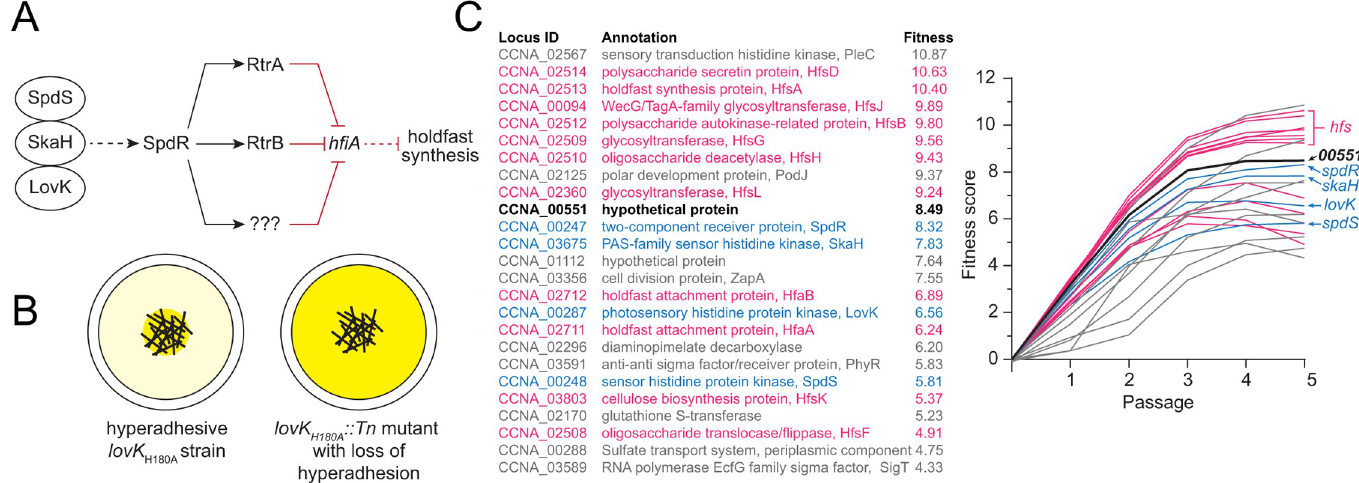
Fig 1. Adhesion TCS pathway and adhesion profiling of lovK H180A :: Tn mutants. A) Schematic of the LovK-SpdSR-SkaH adhesion TCS system that regulates holdfast synthesis as described by Reyes-Ruiz et al. [16]. Question marks indicate postulated additional regulator(s) in the adhesion control pathway. Dashed lines indicate post- transcriptional regulation and solid lines indicate transcriptional regulation. Black arrows indicate activation and red bar-ended lines indicate repression. B) Genetic selection to identify insertions that disrupt the hyper-holdfast phenotype of lovK H180A . Tn- himar strains were cultivated and serially passaged for five days in the presence of cheesecloth (black cross-hatched lines in the center of the well). Mutants that do not permanently adhere to cheesecloth are increasingly enriched in the supernatant with each passage. Darker yellow color indicates non-adhesive lovK H180A ::Tn strains that are enriched after five days of serial passaging. C) (left) List of the 25 genes for which transposon insertion has the largest disruptive effect on adhesion of the lovK H180A strain. (right) Enrichment in the supernatant is reflected in an increasing calculated fitness score with each daily passage. Mutations that disrupt lovK H180A adhesion to cheesecloth include the expected holdfast synthesis and modification genes (pink), and genes encoding the LovK-SpdSR-SkaH regulatory system (blue). The hypothetical gene CCNA_00551 is listed in black; all remaining genes are colored grey.